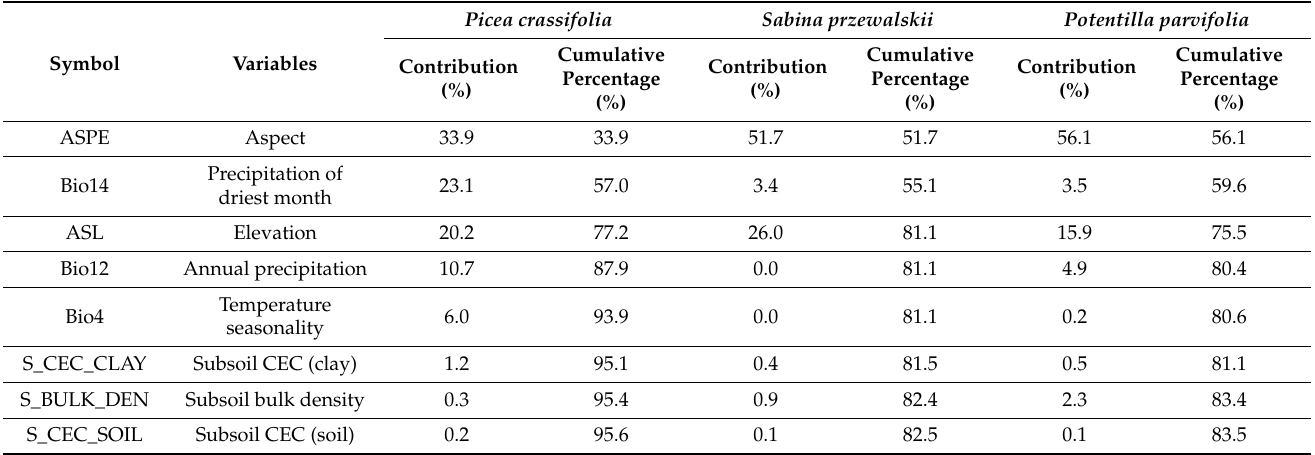
Table 2. The contribution and cumulative percentage of key environmental variables.